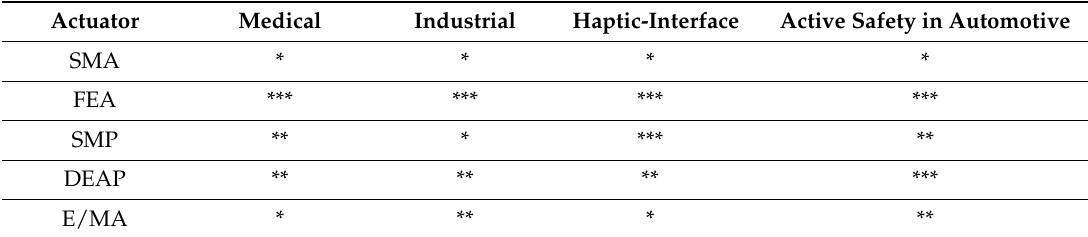
Table 8. Comparison of actuators based on application